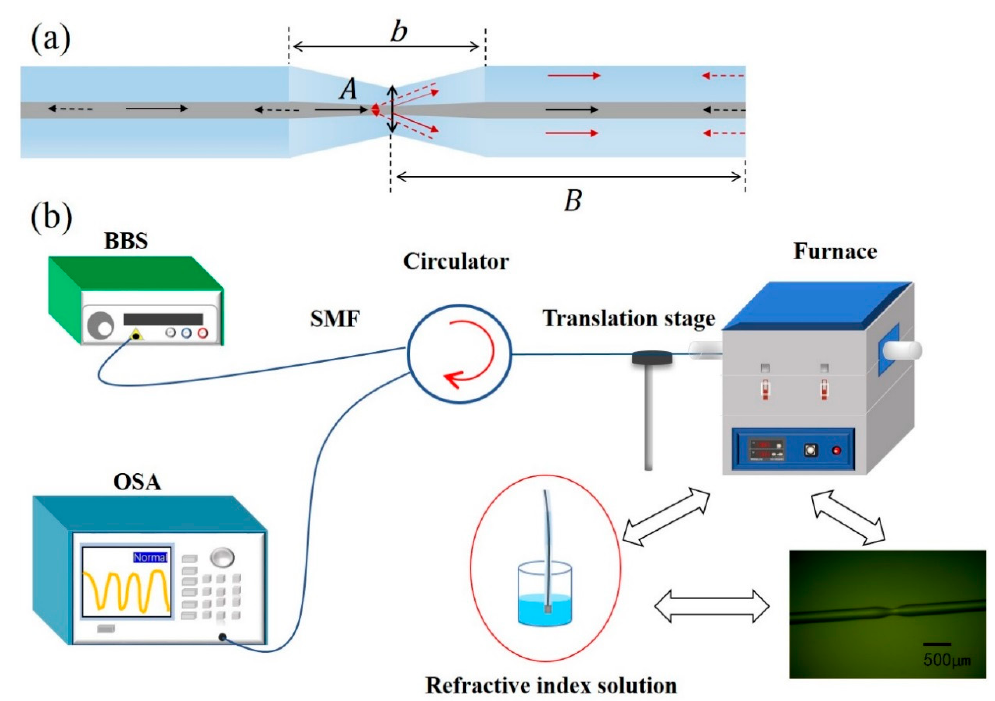
Figure 7. ( a ) Schematic diagram of the probe-type MZI. ( b ) Experimental setup. The inset figure is the optical microscope image of the probe-type MZI. BBS: Broadband source; OSA: Optical spectrum analyzer; SMF: Single mode fiber.